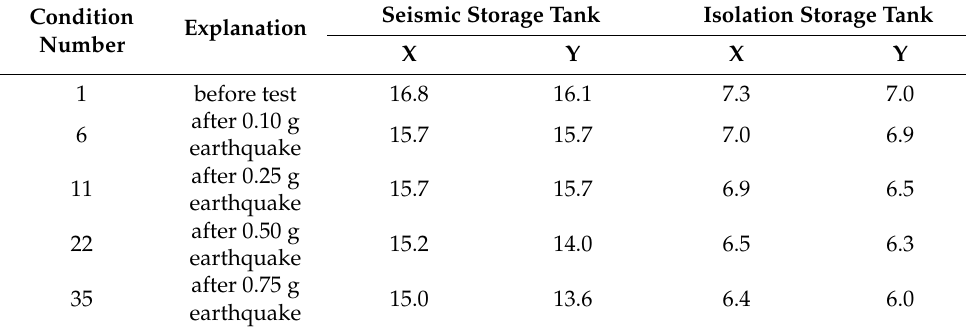
Table 3. Natural vibration frequency of tank model under white noise excitation